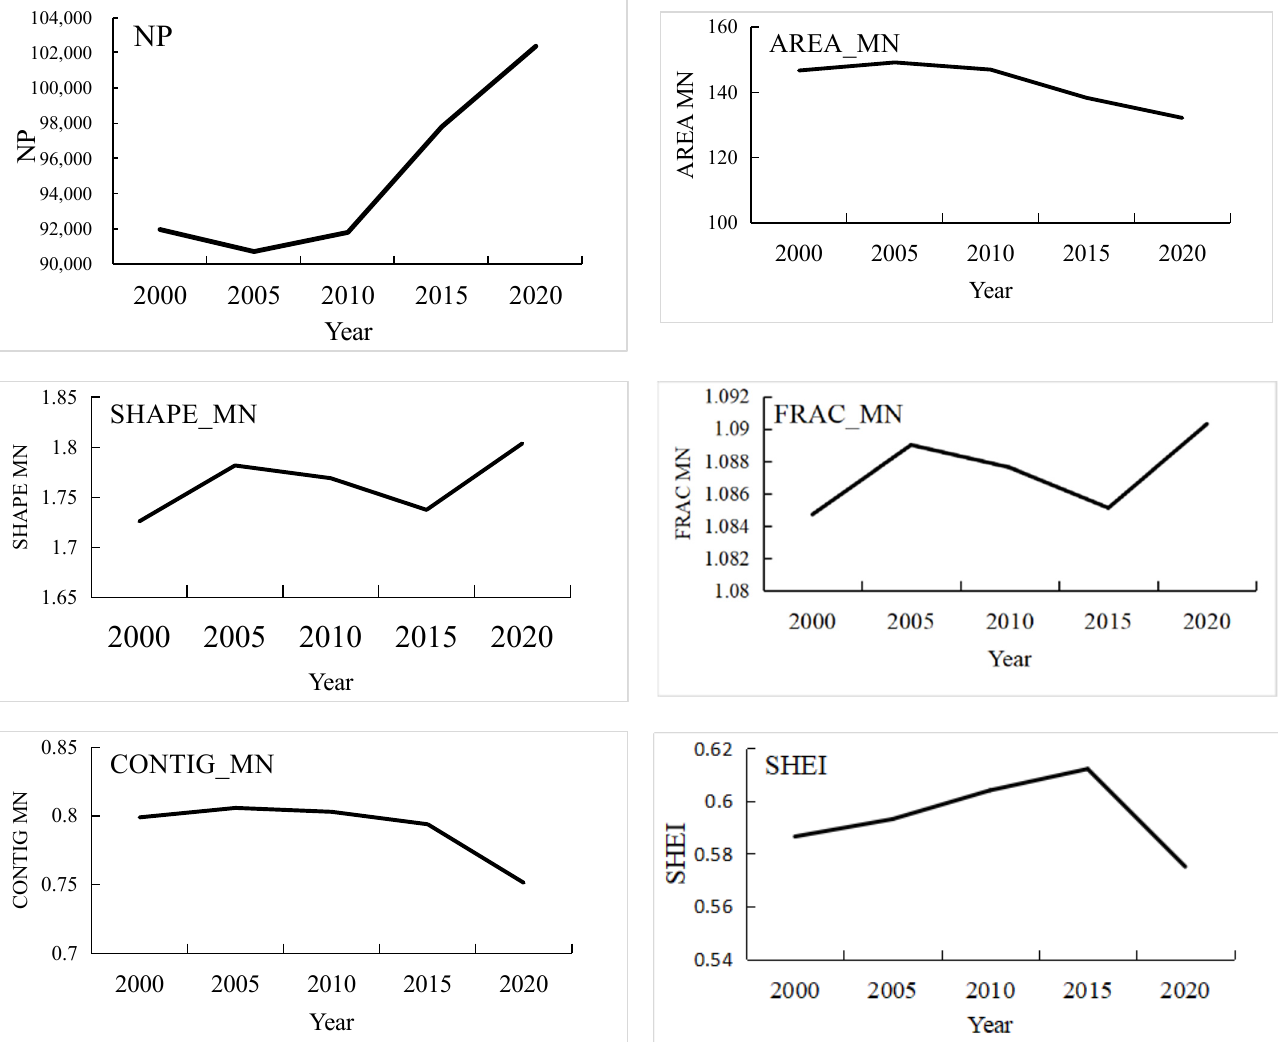
Figure 11. Landscape Pattern Index for Western Hubei Province in 2000, 2005, 2010, 2015, 2020. (CONTIG—Contiguity Index; FRAC—Fractal Dimension Index; NP—Number of Patches; SHEI— Shannon’s Evenness Index).